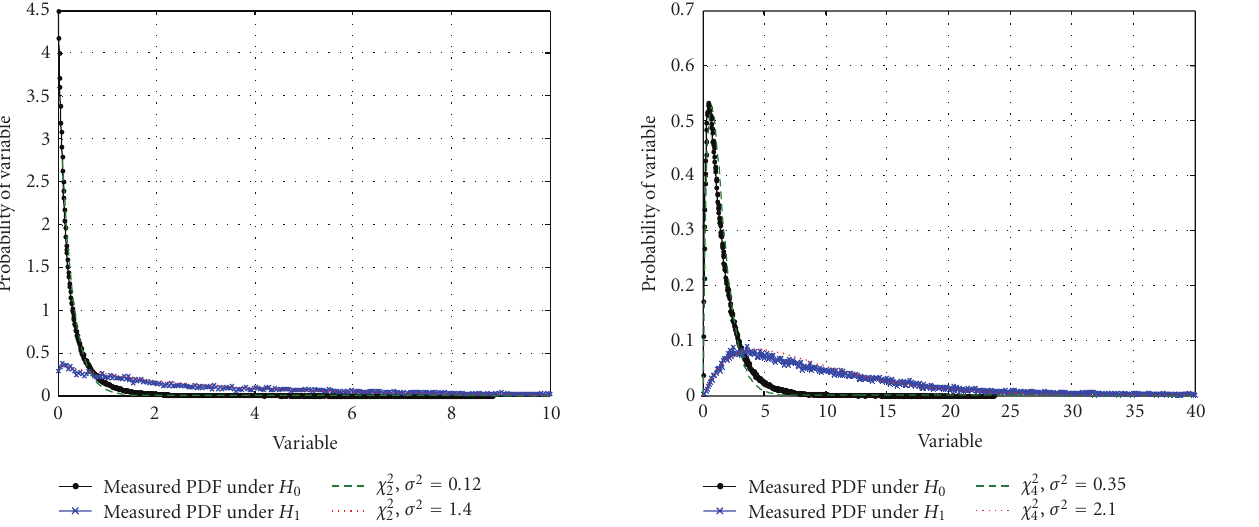
Figure 8: Numerically calculated PDF under H 0 and H 1 states for a static antenna.